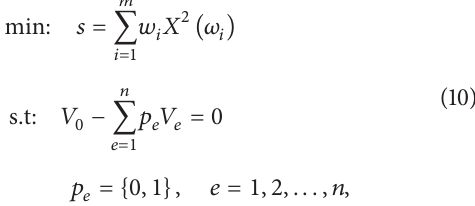
Figure 1: Relationship between loss factor 𝜂 and damping ratio 𝜉